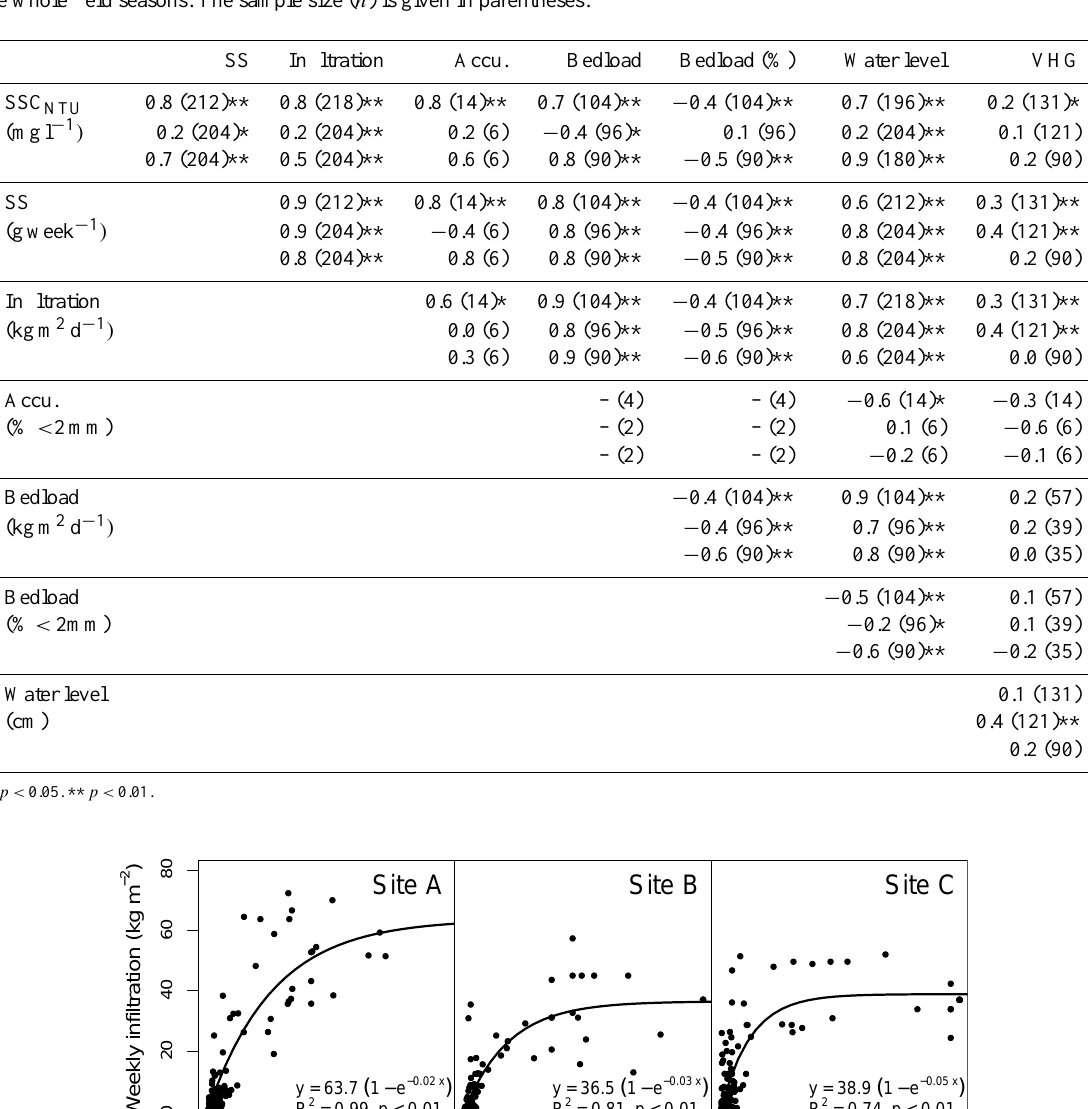
Table 8. Spearman rank correlation coefficients (ρ) between the measured parameters of both seasons for the three sites with mean weekly SSC NTU measured with OBS sensors, total weekly suspended sediment (SS) load measured by SS samplers, daily fine sediment infiltration rate, fine sediment accumulation, daily bedload of fine sediment, the percentage of fine sediment of the total bedload, highest mean daily water level of a week and vertical hydraulic gradient (VHG). The accumulation baskets were correlated with the mean values of the parameters during the whole field seasons. The sample size ( n ) is given in parentheses.